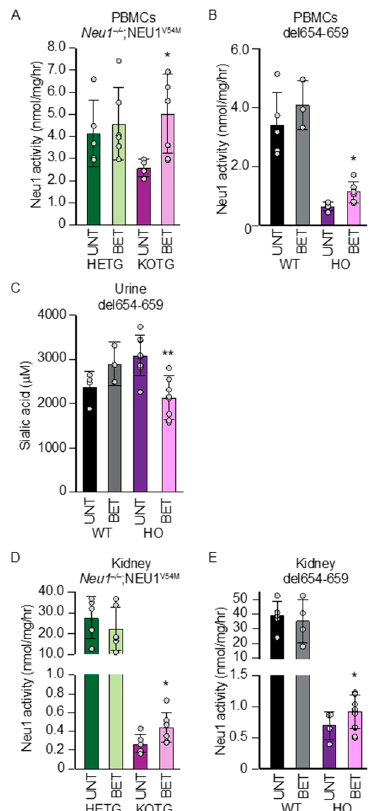
Figure 5. Betaine modulates Neu1 levels in vivo in mouse models with Neu1 residual activity. ( A , B ) Neu1 activity assayed in peripheral blood mononuclear cells (PBMCs) isolated from Neu1 +/ − ; NEU1 V54M (HETG), Neu1 − / − ; NEU1 V54M (KOTG) ( A , n ≥ 4) and mice homozygous for the del654-659 (HO) ( B , n ≥ 3). ( C , n ≥ 3) sialic acid content in the urine of untreated and betaine-treated del654-659 (HO). Neu1 activity assayed in the kidneys of untreated and betaine-treated KOTG ( D , n ≥ 5) and del654-659 (HO) ( E , n ≥ 4) respectively. Graphs are presented as mean ± SD. Statistical analysis was performed using Student t -test. * p < 0.05, ** p < 0.01.